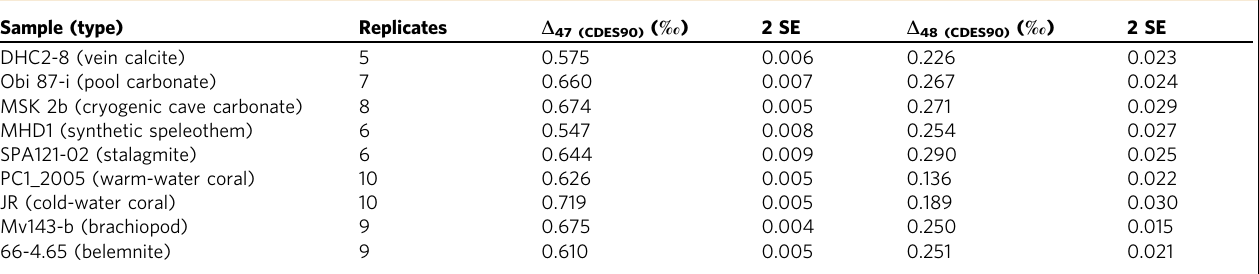
Table 2 Clumped isotope composition ( Δ 47 (CDES90) and Δ 48 (CDES90) ) of the samples. Sample